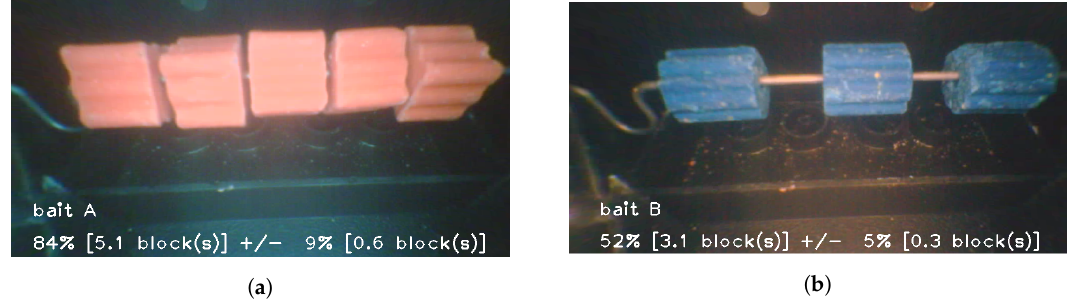
Figure 9. Image processing outputs for bait identification and bait level estimation. ( a ) Five blocks of red bait detected; ( b ) Three blocks of green bait detected.